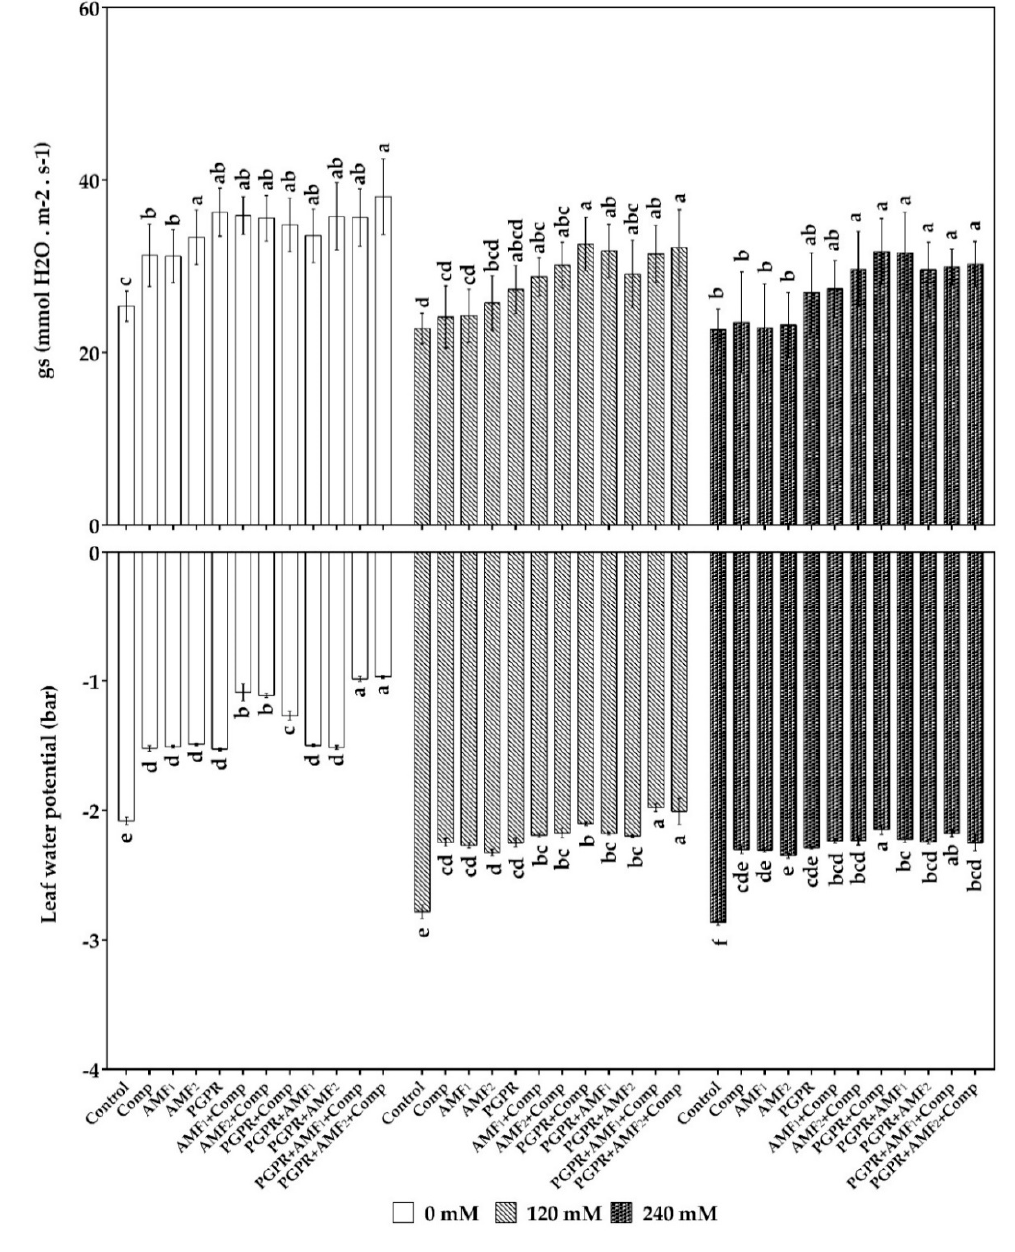
Figure 3. Effects of salt stress and biofertilizers on gas exchange (gs) and leaf water potential of date palm vitroplants. Comp: compost; AMF1: AMF consortium; AMF2: AMF pure strain; PGPR: plant growth promoting rhizobacteria. Data presented are means ± standard deviations, (gs: n = 8; Ψ : n